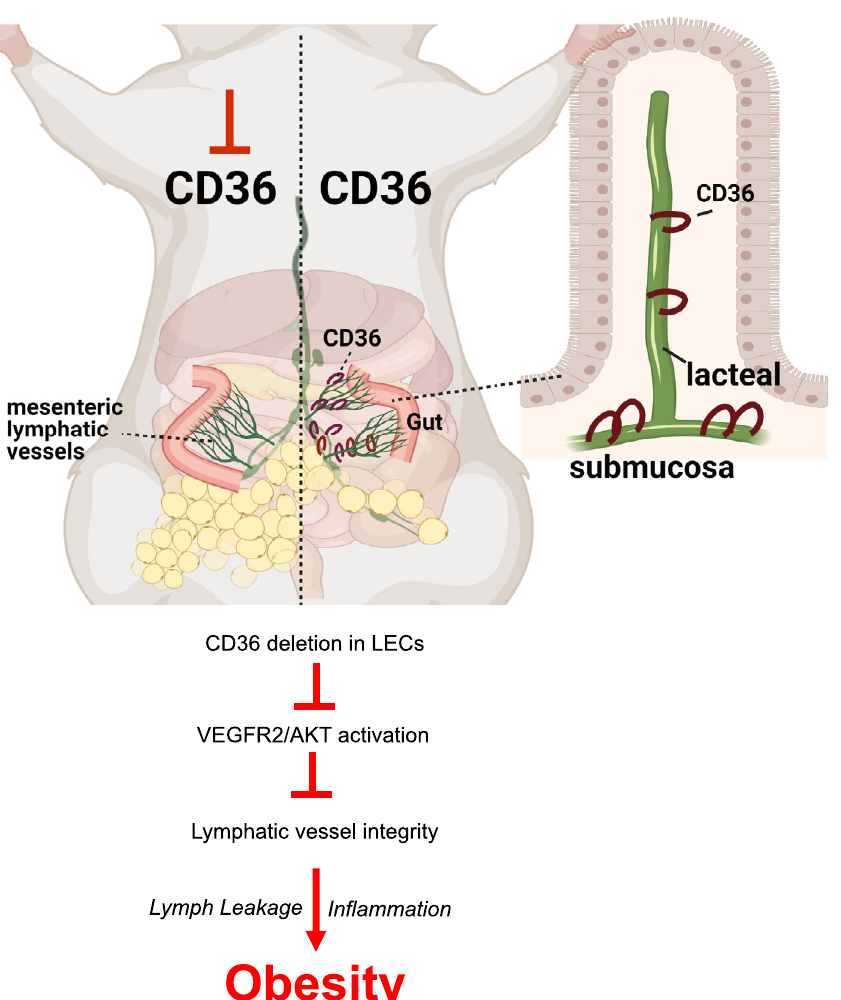
Fig. 9 CD36 deletion in lymphatic endothelial cells associates with obesity and glucose intolerance. CD36 expression in lymphatic endothelial cells (LECs) follows an increasing gradient from gut mucosa to submucosa to collecting mesentery vessels. CD36 deletion in LECs in adult mice ( Cd36 Δ LEC ) increases discontinuity of VE-cadherin junctions and associates with lymph leakage in the mesentery. In fl ammation of visceral fat, age-associated obesity and glucose intolerance are observed in 20-week-old Cd36 Δ LEC mice. The mechanism likely involves reduced signaling of VEGF-C in LECs, which leads to disorganization of LEC junctions and impairs cell migration and tube formation. Image created using 37 °C). Migration was stimulated by adding 100 ng/ml VEGF-C (R&D System) and protocols for the animal studies were reviewed and approved by the animal Ethical 25 ng/ml β -FGF to the lower well. LECs migrated for 24 h then supernatants were Committees at Washington University School of Medicine. aspirated, the inserts washed and fi xed with ice-cold methanol and LECs stained with Hoechst dye. Images of the lower side of inserts were taken and nuclei of Flow cytometry and LEC sorting . Intestines were separated off the mesentery. The migrated cells/well quanti fi ed using ImageJ v1.53i software (NIH). Tube formation jejunum was then opened longitudinally and, after removal of Peyer ’ s patches, was assayed in basal medium supplemented with 2% FCS, 100 ng/ml VEGF-C, and gently scraped off to physically separate the mucosal layer (lacteals) from the 25 ng/ml β -FGF. Ctrl and CD36 siRNA-treated LECs (25,000 cells/well) were submucosa by using a cell scraper. The submucosa was washed twice with DTT/ seeded in 48-well plates with wells pre-coated with growth factor-reduced Matrigel EDTA on a shaker at 37°C, followed by enzymatic digestion using the Miltenyi (150µl solidi fi ed at 37 °C for 30min). Bright fi eld images of capillary-like tubes Lamina Propria Dissociation kit (Miltenyi Biotech) for 30min, per manufacturer ’ s were taken after 12 h at 37 °C for quanti fi cation. Mean tube length and branch instructions, whereas gut mucosa and mesentery were directly digested for 30 min. points were quanti fi ed using ImageJ v1.53i software. The three cell suspensions were stained with an antibody cocktail (Supplementary Table 1). CD36 expression was measured on LECs identi fi ed as CD45 − CD90.2 + Seahorse . Oxygen consumption rate (OCR) and basal extracellular acidi fi cation CD31 + 70 . Doublets and dead cells, positive for LIVE/DEAD Fixable Aqua (Life rate (ECAR) values were obtained using the XFp Mito Stress Kit using the Seahorse Technologies), were excluded from analyses. Cells were analyzed using FACS XF96 Extracellular Flux Analyzer (Seahorse Biosciences). Brie fl y, LECs (2.5 × 10 5 Fortessa (BD Biosciences) and FlowJo v10 software (Treestar). LECs were sorted (BD FACSAria II, BD Biosciences) by the tdTomato-positive population in jeju- cells/well) were plated in XF96 cell plates 24h before the assay and treated 16h num of control and Cd36 Δ LEC mice. with/without 100 ng/ml VEGF-C (R&D System). Before assay, cells were switched to bicarbonate free media supplemented with pyruvate (1 mM), glucose (10 mM), and glutamine (2 mM) and kept 1 h in a non-CO 2 incubator at 37°C. Oligomycin Endothelial cell tube formation and migration assays . Human Dermal LECs, (3 μ M), carbonyl cyanide-p tri fl uoromethoxyphenylhydrazone (FCCP, 2.5 μ M) and from PromoCell were cultured in EBM-2MV medium (Lonza). For siRNA treat- antimycin A/rotenone (2 μ M) were added to the appropriate injection ports. ment, the LECs were grown to 60 – 80% con fl uence and transfected with either control or CD36 Silencer ® Pre-designed siRNA, as per the manufacturer ’ s Western blotting . Overnight serum-starved LECs were treated with 100 ng/ml instructions (Ambion). The Boyden chamber migration assay was performed using serum-starved Ctrl and CD36 siRNA treated LECs (50,000 cells/insert) grown on VEGF-C (R&D System) for 20min at 37°C, lysed (20 min) in cold buffer (20 mM transwell inserts (8 µm pore size) coated with 10 µg/ml fi bronectin (30 min at Tris-HCL, pH 7.5, 150mM NaCL, 1% Triton X-100, 60 mM octyl β -D-